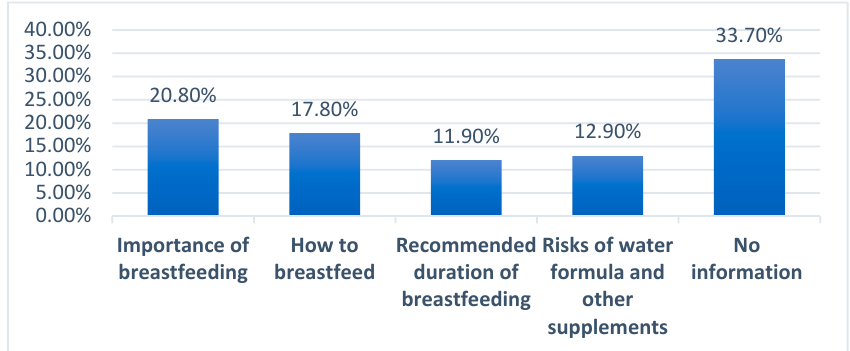
Figure 2. Information given during the antenatal visits.